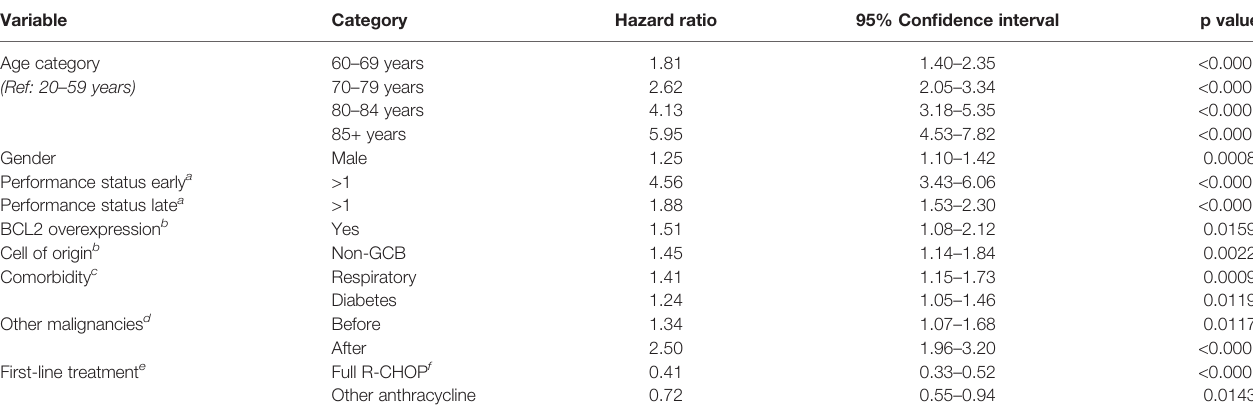
TABLE 4 | Adjusted hazard ratios (HR) from a multivariable analysis based on Cox models including age category, gender, PS, cell of origin, respiratory comorbidity, diabetes, other malignancies, and fi rst-line treatments.